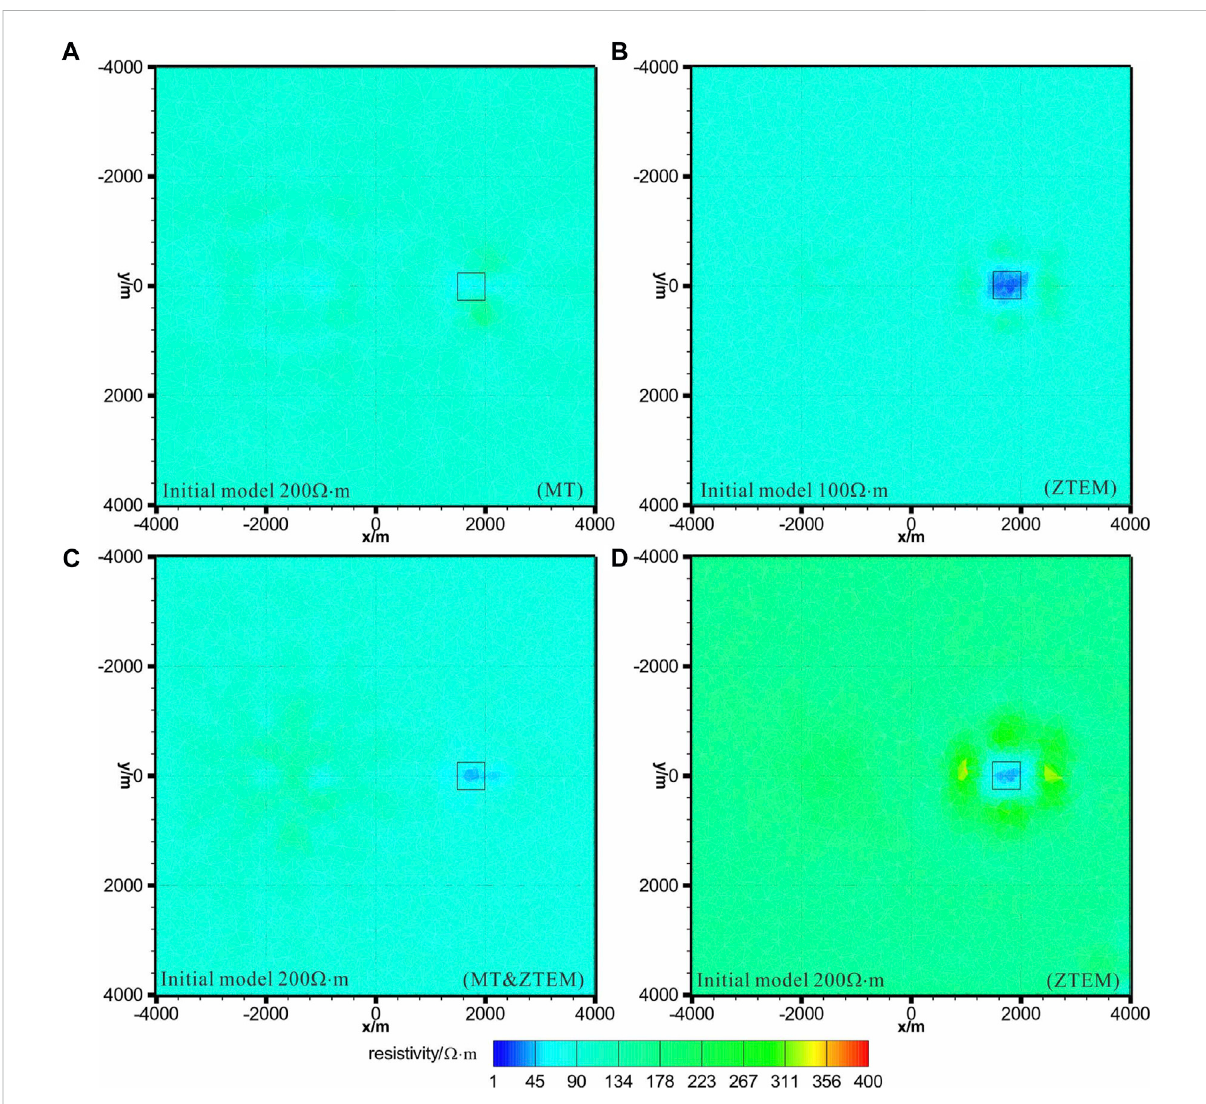
FIGURE 5 Inversionresultsforthesyntheticmodelwithouttopographyat xy sectionfor z = − 450 m. (A,D) and (C) aretheMTinversion,ZTEMinversion,and joint MT and ZTEM inversion with initial model and a 200 Ω · m half-space, respectively. (B) is the ZTEM inversion with a 100 Ω · m